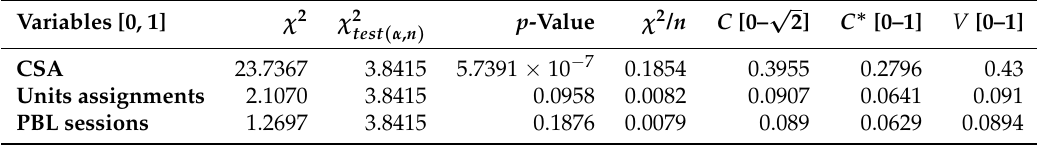
Table 8. Association parameters and χ 2 test between the grades obtained by students (pass or fail) and the use of CSA; units assignments; and PBL sessions.